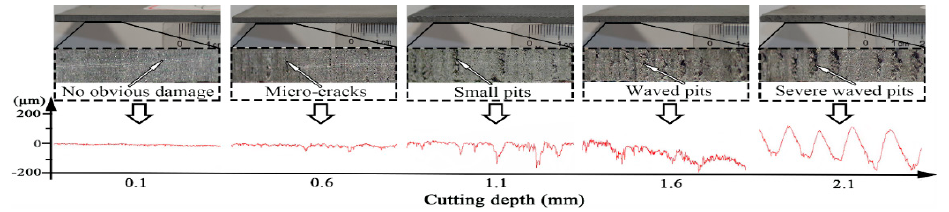
Figure 12. Machined surface of workpiece planed at different cutting depths.